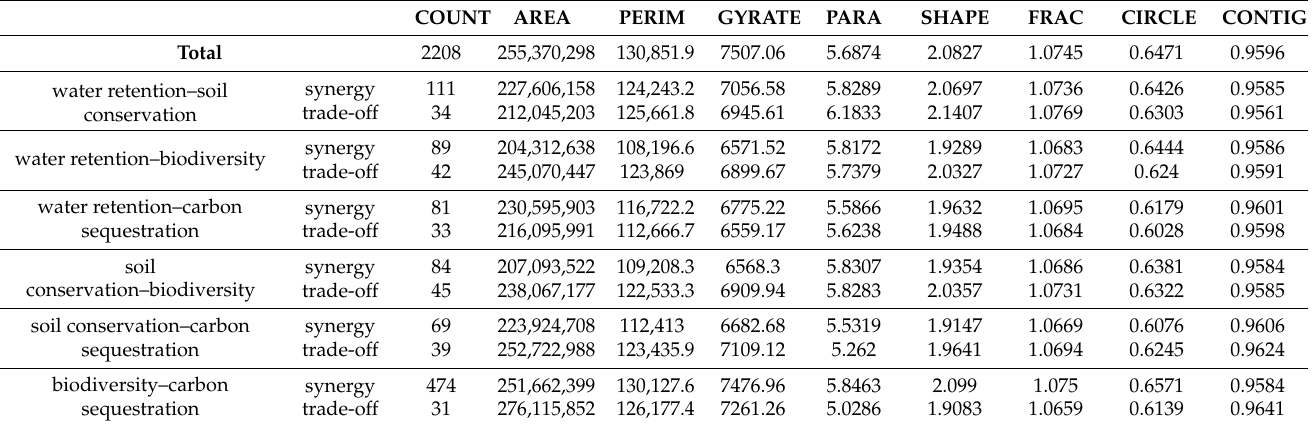
Table 3. Ecosystem service synergy/trade-off pattern index